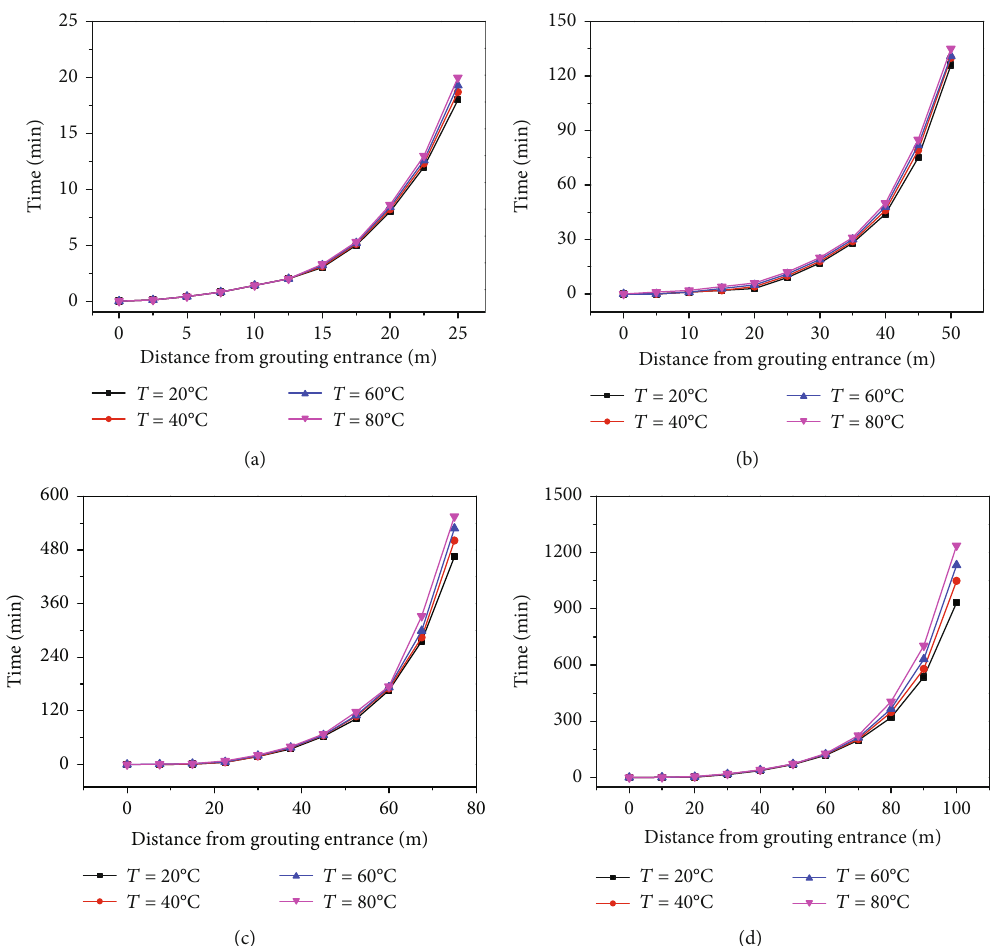
Figure 5: The time it takes for the grout to pass through di ff erent distances in the fracture with di ff erent lengths: (a) 25m, (b) 50 m, (c) 75 m, and (d)